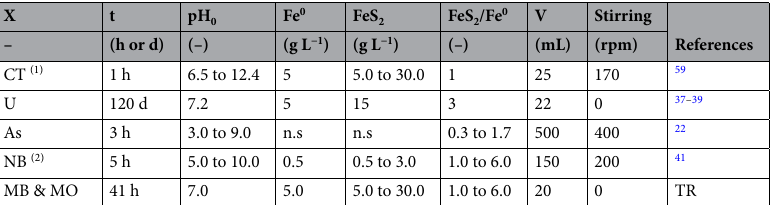
Dye discoloration in Fe 0 /sand/H O systems. Figure 3a shows the extent of dye discoloration (E values) 2 by the ternary system as the FeS 2 loadings increase from 0 to 30 g L −1 . Figure 3b depicts the variation of E values as a function of the final pH value. It is evident that there is a general linear decrease in E value with increasing FeS 2 loading or decreasing pH values (Fig. 2a). However, three important issues have to be considered: (i) the highest E value for each system corresponds to [FeS 2 ] = 0 g L −1 (Issue 1); (ii) for [FeS 2 ] = 5 g L −1 and [FeS 2 ] > 20 g